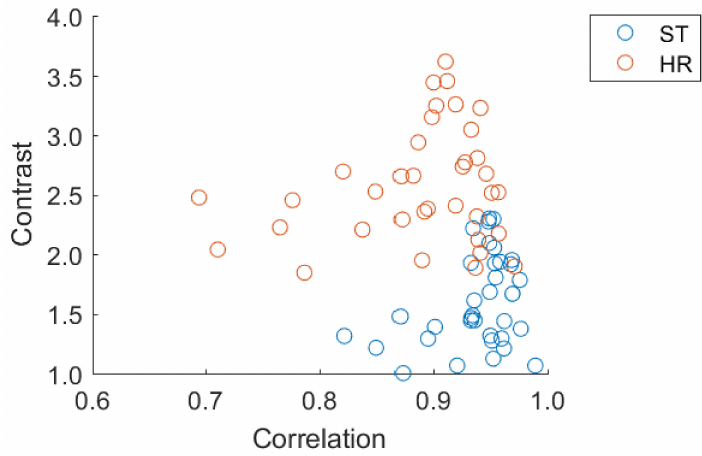
Figure 4. Boxplots of Mean ( a ) and Variance ( b ) histogram-based features. These features show no significant di ff erence between 15 ◦ acquisition angle (standard mode) and 40 ◦ acquisition angle (high resolution mode) DBT images.